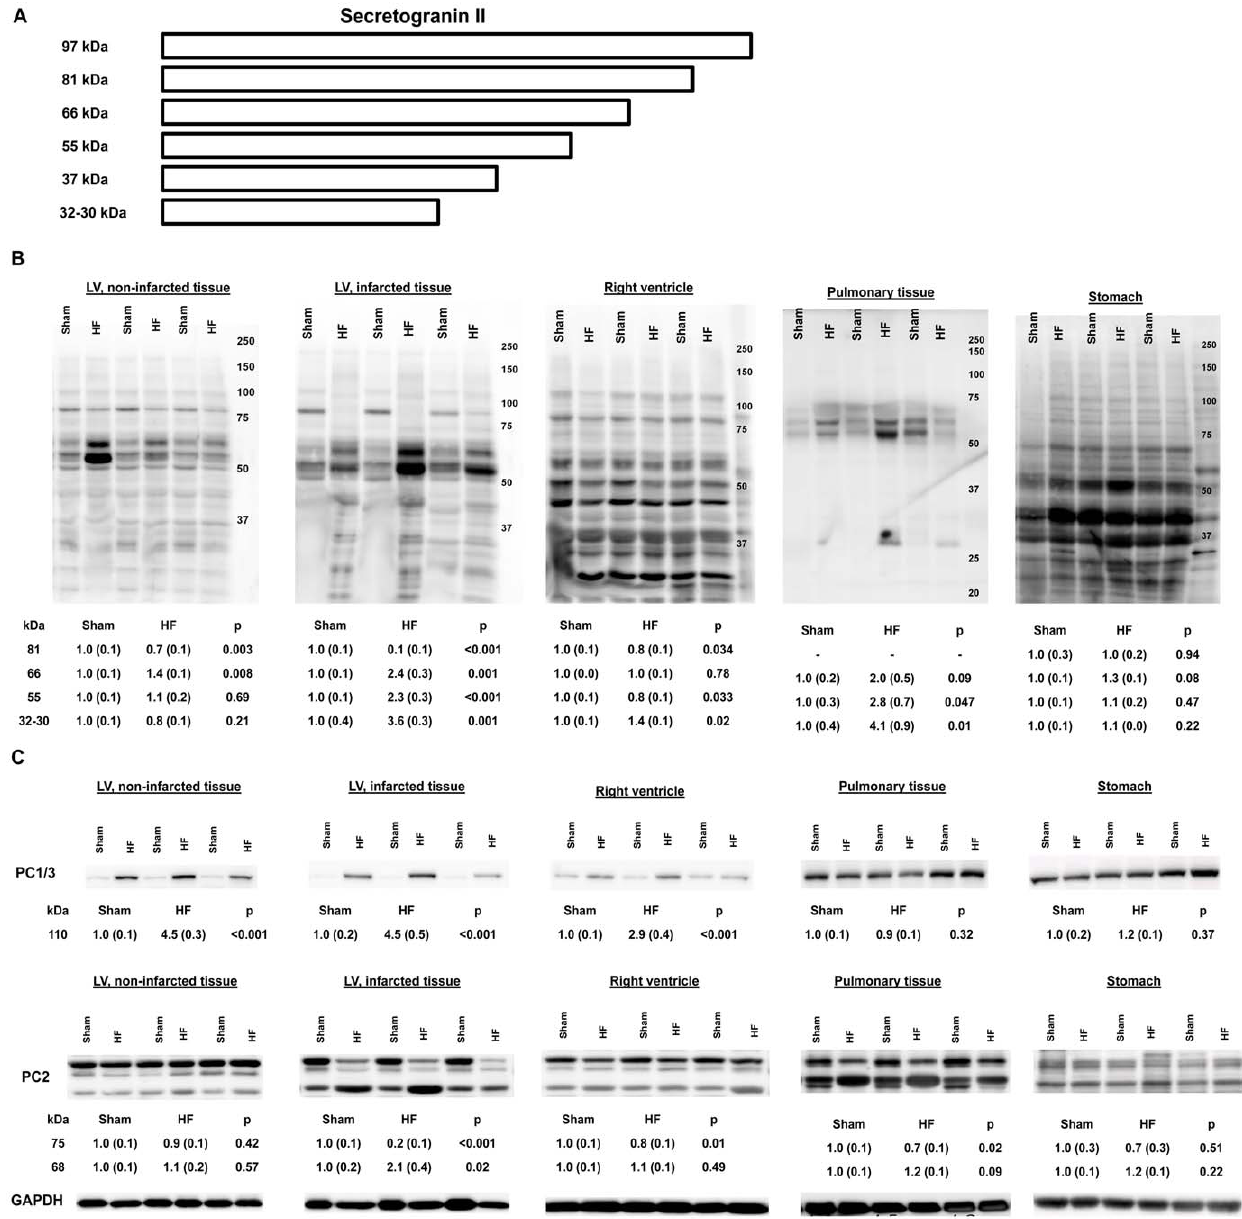
Figure 2. SgII is produced by cardiomyocytes and increased in the left ventricle during HF development. A, SgII protein levels as measured by RIA were increased in both the non-infarcted and infarcted region of the LV in HF animals compared to levels in the myocardium of sham-operated animals (n=9 for both groups). B, Representative photomicrographs of myocardial tissue sections of a HF mouse demonstrating SgII immunoreactivity (brown staining) in cardiomyocytes of the non-infarcted LV (upper left image). Images of the area bordering the infarcted zone (border zone) are presented in the upper right image (magnification: 6 100) and the lower left image (magnification: 6 400) and demonstrate SgII immunoreactivity also in non-cardiomyocyte cardiac cells, including fibroblasts. In the upper right image, the infarct area is seen on the left side with granulation tissue in between non-infarcted tissue in the center. Bottom right picture demonstrates very weak staining after use of non-immune rabbit serum as control (ctr). Magnification: 6 100 except lower left image ( 6 400). C, SgII mRNA levels were measured in fractions of cardiomyocytes (n=5), endothelial cells (n=2), and non-cardiomyocytes, non-endothelial cells (n=5) extracted from LV tissue. Gene expression was measured by RT- qPCR and is presented as fold change 6 SEM vs. levels in the cardiomyocyte fraction. **p , 0.001, *p , 0.01.